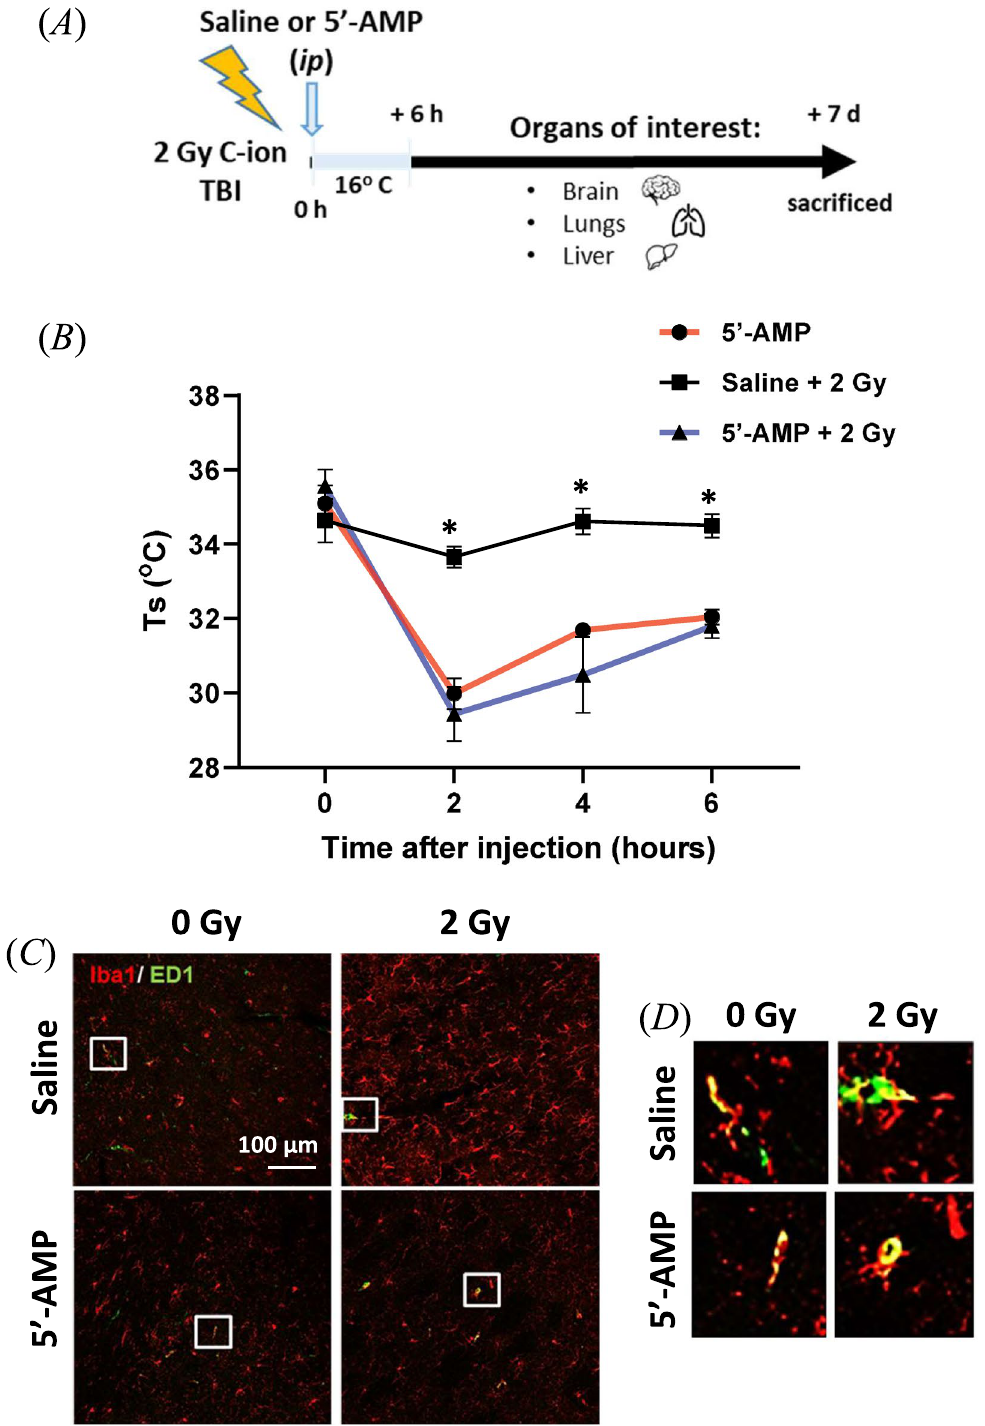
Figure 2. The 5 ′ -AMP injection reduced activated microglia and maintained the number of resident macrophages. ( A ) Experimental setup for radiation, hypothermia induction, and analysis of the organs. ( B ) The 5 ′ -AMP administration, in combination with a low ambient temperature (Ta 16 °C), decreased their skin temperature (Ts) up to a moderate level of 27–32.9 °C. ( C ) representative pictures and ( E ) the number and the size of Iba-1 positive cells (red) one week after 2 Gy of C-ions irradiation increased in rats treated with saline injection compared to the 5 ′ -AMP treated and control non- irradiated rats (n = three rats; 5 slices from each rat). ( D ) Resident microglia with phagocytic function recognized as ED1 + / Iba-1 + (green/ red). ( F ) The 5 ′ -AMP injected rats had the same number of ED1 + /Iba-1 + cells in control not-irradiated rats, while rats treated with saline injection significantly lowered the ED1 + /Iba-1 + cells one week after irradiation. ( G and H ) Irradiation increased the soma area of Iba-1 positive cells (green), while 5 ′ -AMP injected rats had an increase compared to control animals and smaller size than saline-injected irradiated rats. Data are presented as the mean 6 SEM. * P < 0.05; ** p < 0.01. Sham treatment, n = 12 slices (3 animals); 5 ′ -AMP, n = 15 slices (3 animals); Saline + 2 Gy, n = 15 slices (3 animals); 5 ′ -AMP + 2 Gy, n = 12 slices (3